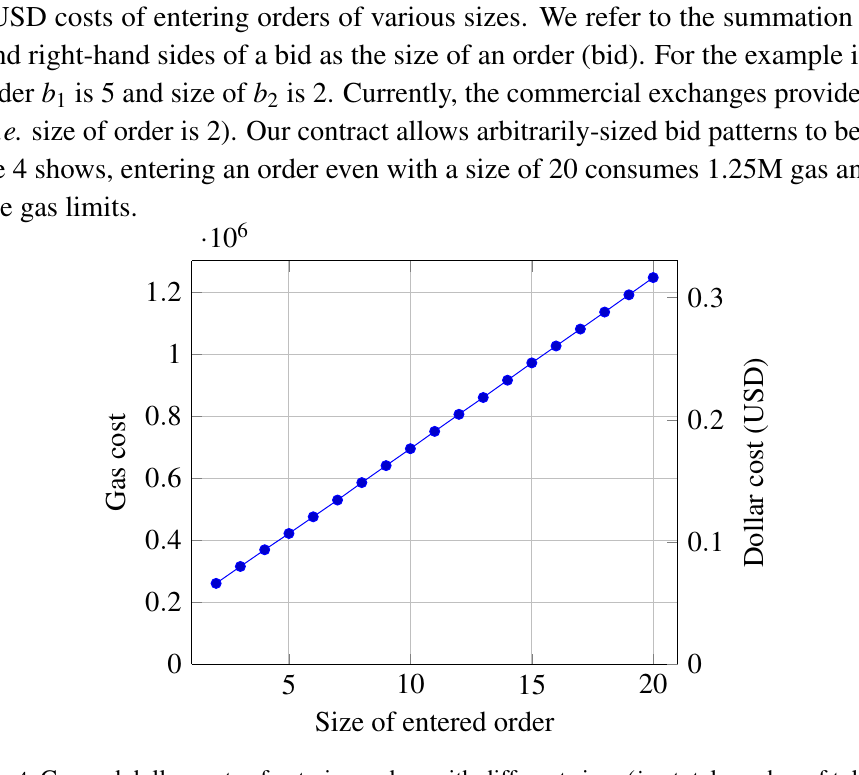
Fig. 4. Gas and dollar costs of entering orders with different sizes ( i.e. total number of tokens in the left and right sides of